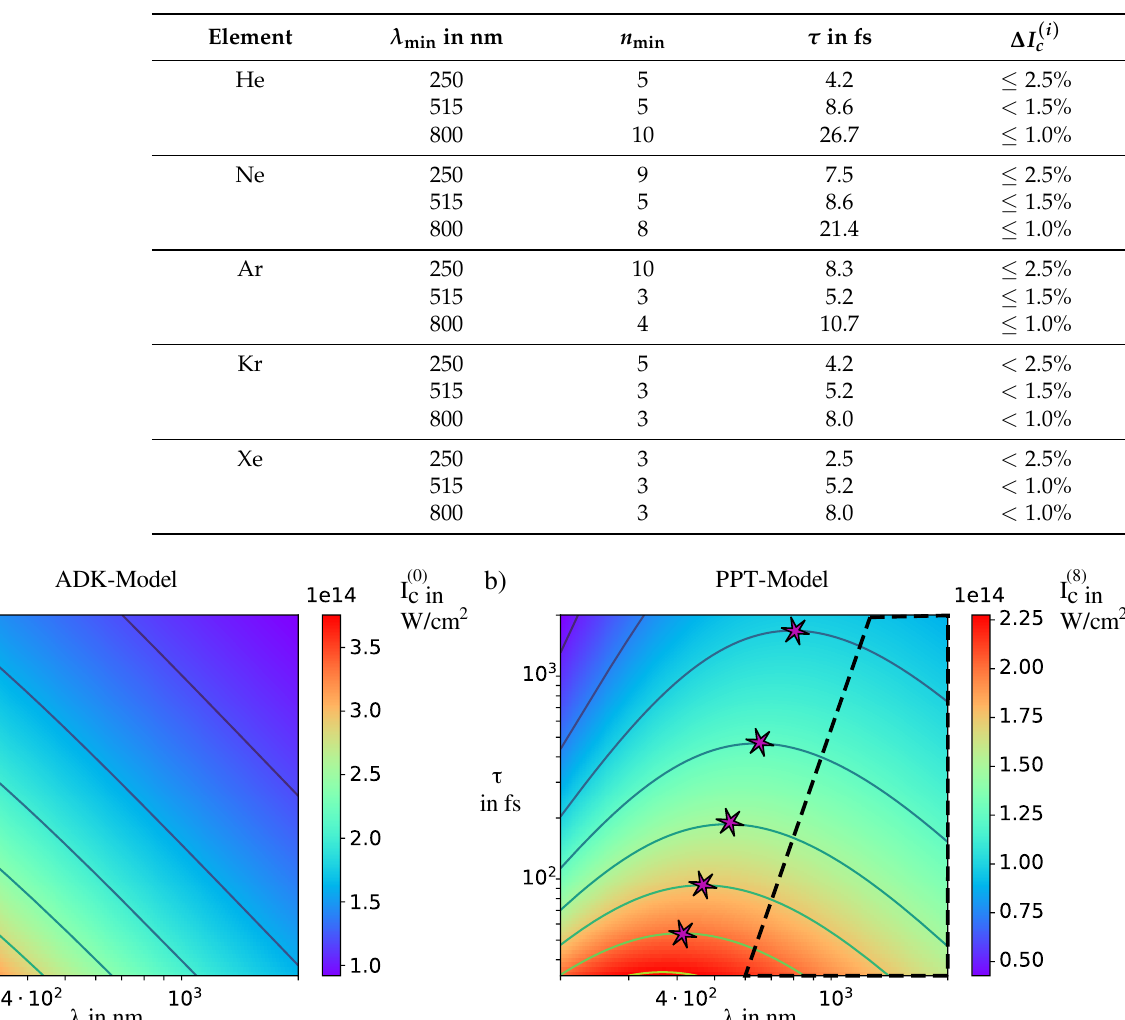
Table 3. Accuracy of the critical intensity in the PPT model (41). The table is showing the lower limit of the parameters with the respective wavelength λ min , number of optical cycles n min , and the resulting pulse duration τ min ∝ λ min n min for which the error of the critical intensity is smaller than ∆ I ( 0 ) c . The iteration parameter i is not fixed and is chosen such that the critical intensity is converged. We fixed the HH photon energy to 50eV such that the critical intensity remains roughly constant for higher photon energies and, thus, the change in the error for lower photon energies is reasonably small.